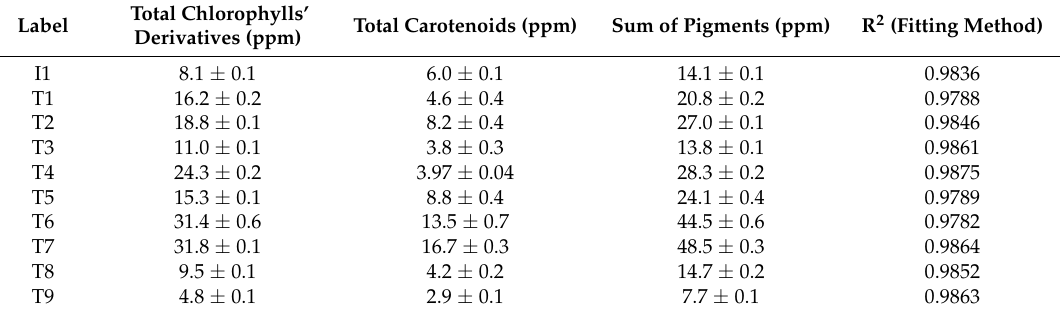
Table 3. Values of total chlorophylls’ derivatives, total carotenoids, and sum of pigments, as determined by the second method (Domenici et al. [17]). Values are reported as mean ± confidence interval (CI) of three